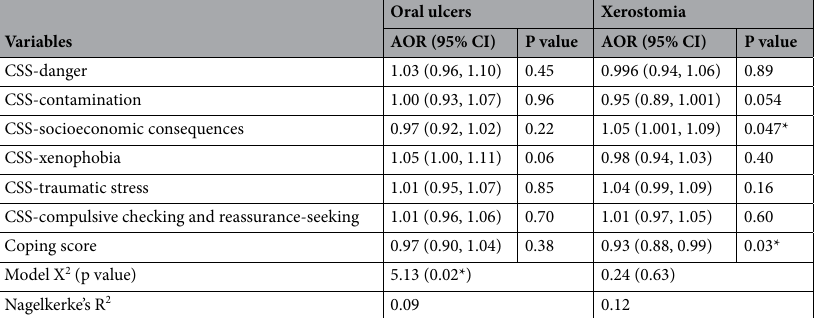
Table 3. Association of COVID-19 specific stresses and coping with reported oral ulcers and xerostomia. AOR Adjusted odds ratio, CI confidence interval. *Statistically significant at p value < 0.05. Both models were adjusted for age in years, sex, and highest educational level, history of COVID-19 infection, having a close friend testing COVID-19 positive, knowing someone who died of COVID-19, smoking, toothbrushing, dental visits, and sugar consumption. The model for oral ulcers was additionally adjusted for xerostomia. In the xerostomia model, the E value of the CSS- Socioeconomic consequences subscore = 1.18 and the E-value of the coping score =